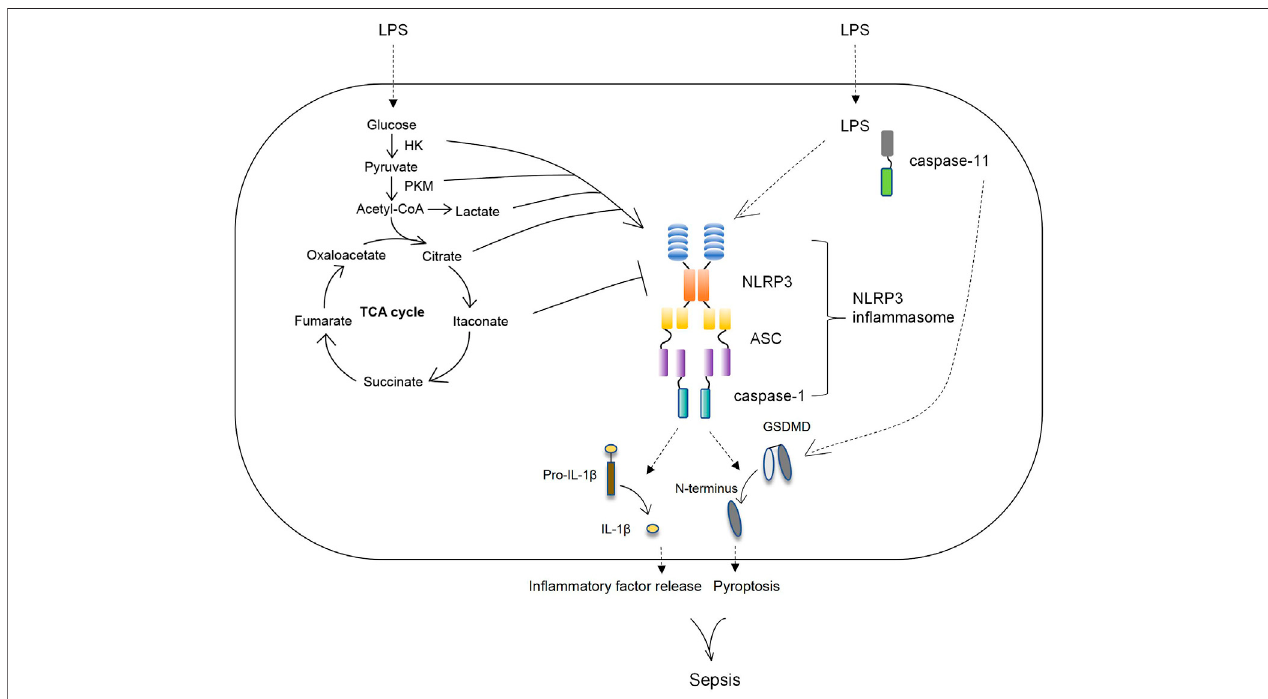
FIGURE 1 | The key enzymes and metabolic intermediates participated in the activation of NLRP3 in fl ammasome. During sepsis the glucose metabolism of macrophagewaschanged,manifestedbyincreasedglycolysisanddecreasedTCAcycle/OxPhosaswellasenrichedvariousTCAcyclemetabolites.Subsequently,the key enzymes and intermediates of glucose metabolism in macrophage regulated the activation of NLRP3 in fl ammasome to affect macrophage functions. HK and PKM, the keyenzymesofglycolysis, positively upregulatedNLRP3 in fl ammasome. Lactate, themetabolismofglycolysis,as wellas citrate, themetabolismofTCA cycle, increased NLRP3 in fl ammasome activation. Itaconate, the intermediate of TCA cycle, downregulated NLRP3 in fl ammasome